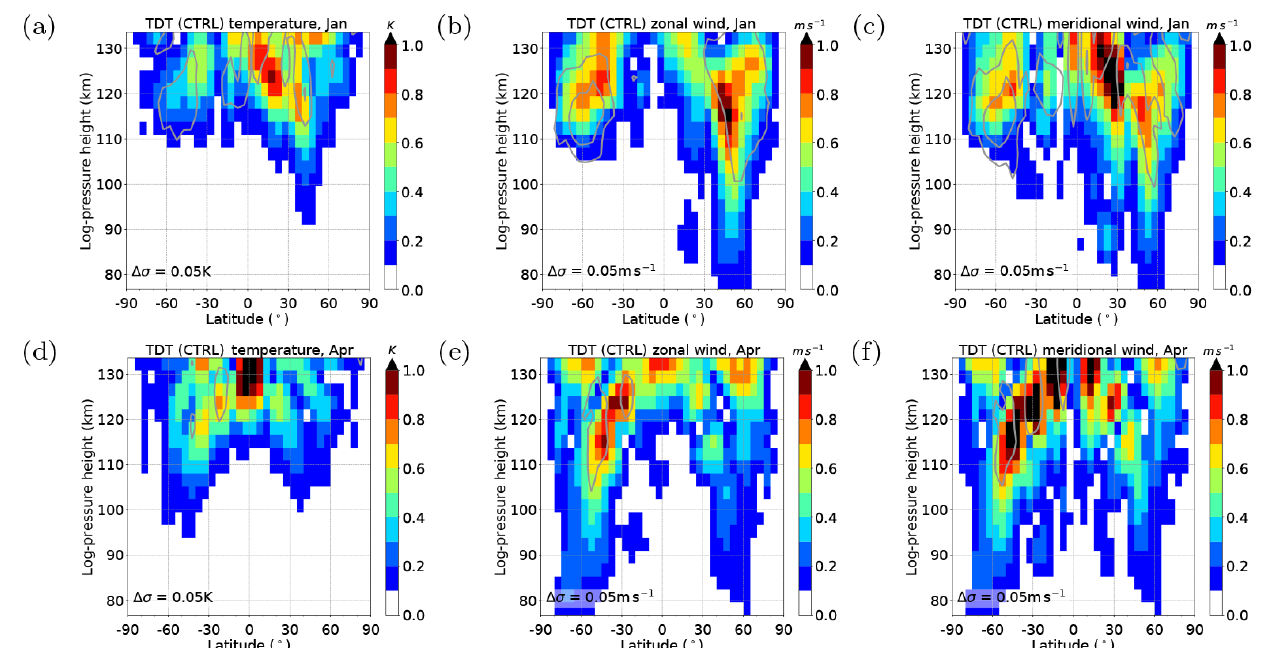
Figure 13. As in Fig. 5 but for CTRL simulation. Note that scales are different.